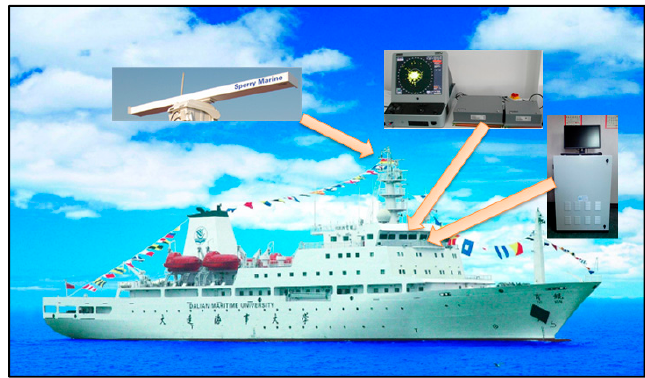
Figure 5. Installation of the ship-borne radar oil spill data acquisition system onboard the Yukun [26]. Table 1. Parameters of the ship-borne radar.